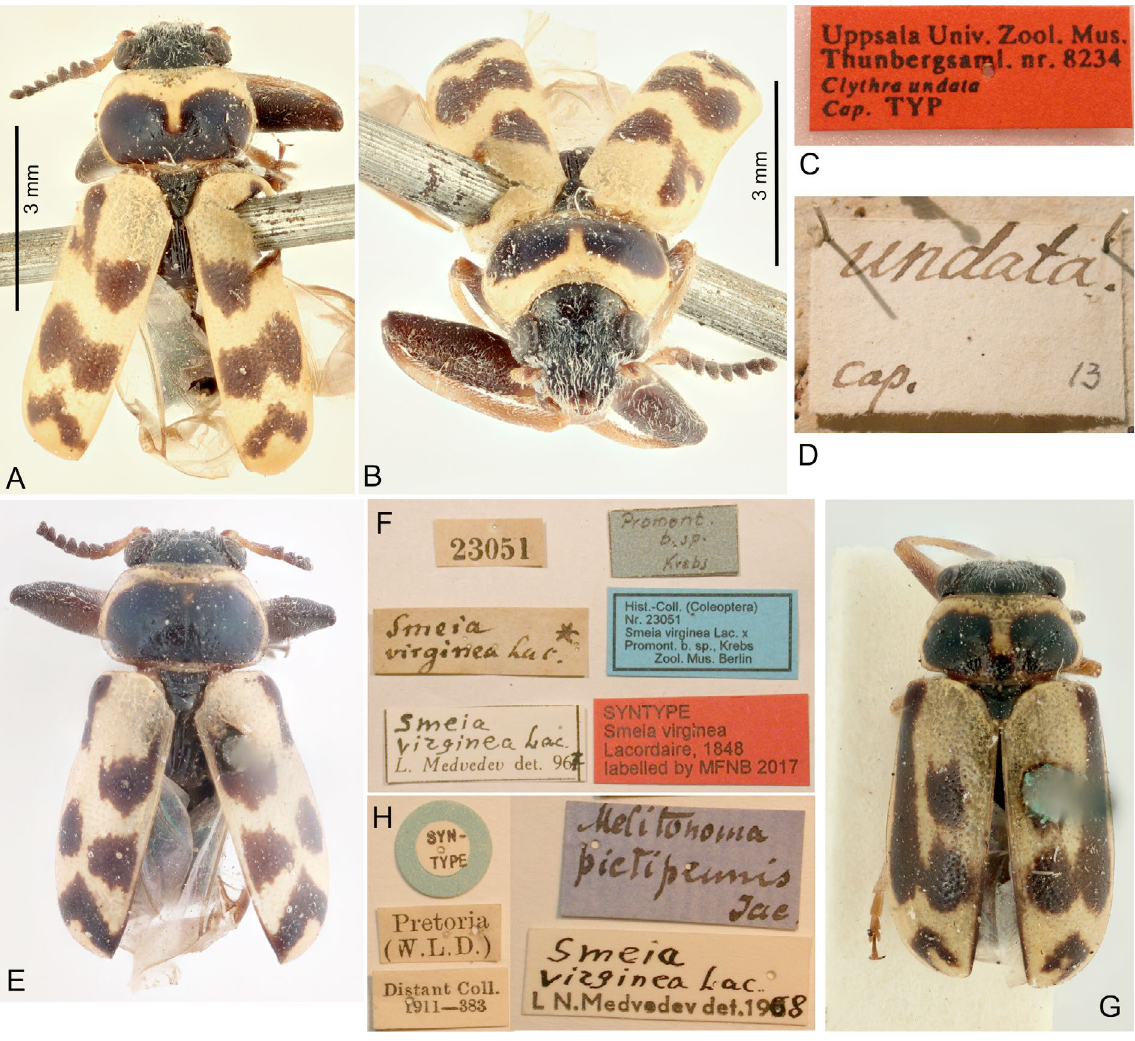
Fig. 12. Smeia undata (Thunberg, 1821) comb. nov. A–D . Holotype, ♂, 6.5 mm, UUZM. A . Dorsal view. B . Frontal view. C . Label. D . Box label. E–F . Syntype of Clythra virginea Lacordaire, 1848, ♂, 1898, ♀, not measured, BMNH. G . Dorsal view. H .